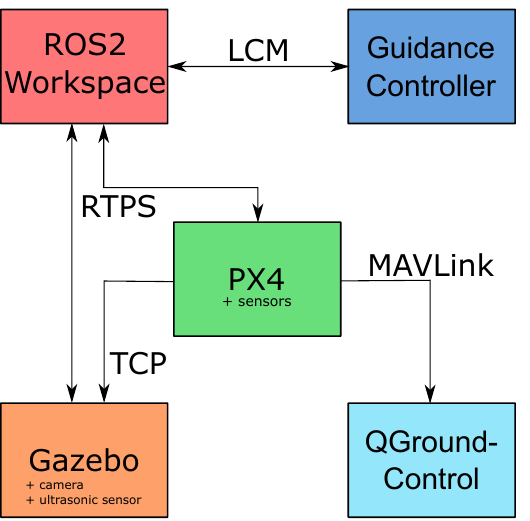
Figure 6. The main blocks composing the software architecture in the ROS2 simulation